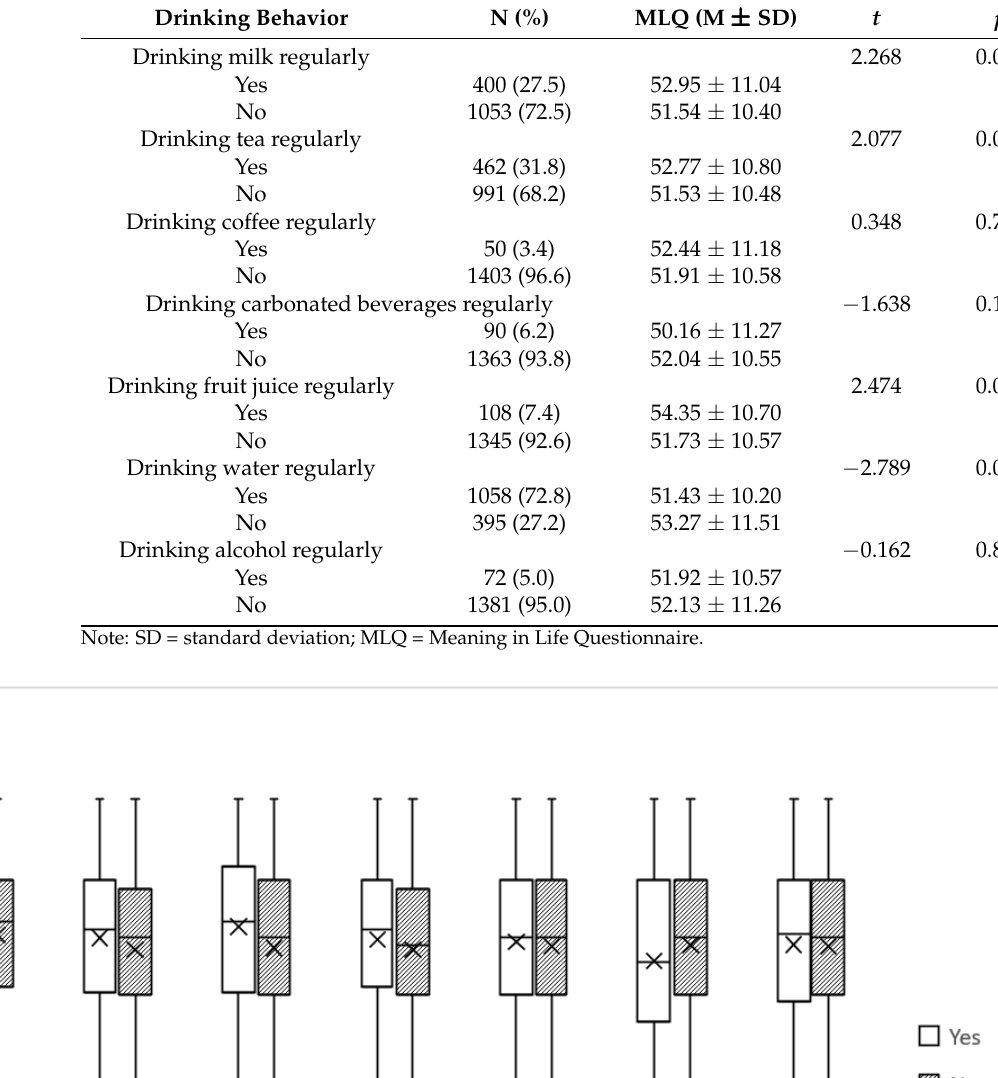
Table 2. The association between drinking behaviors and MLQ among the GPs in Shandong, China.